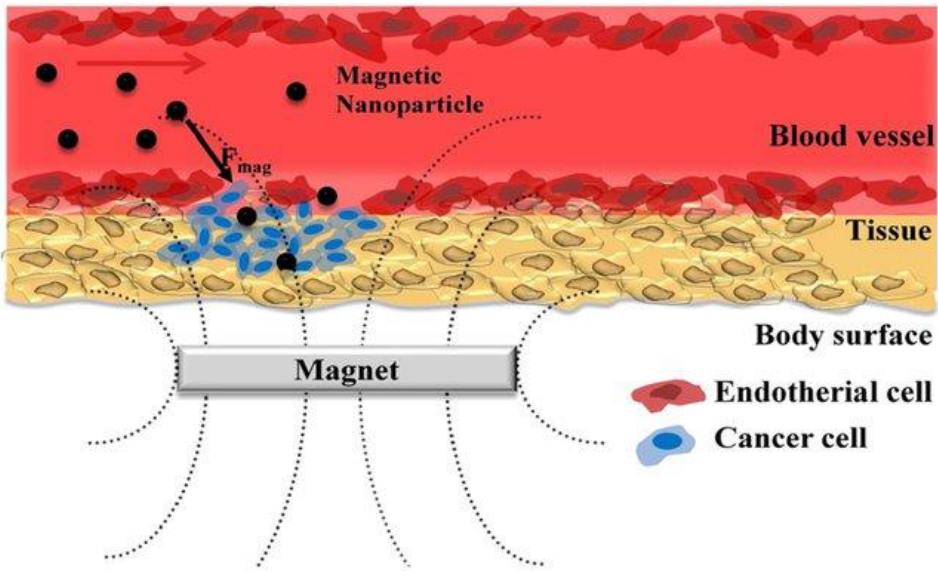
Figure 9. Schematic of an EMF-influenced magnetic drug delivery system. Adapted from Park et al. [71].